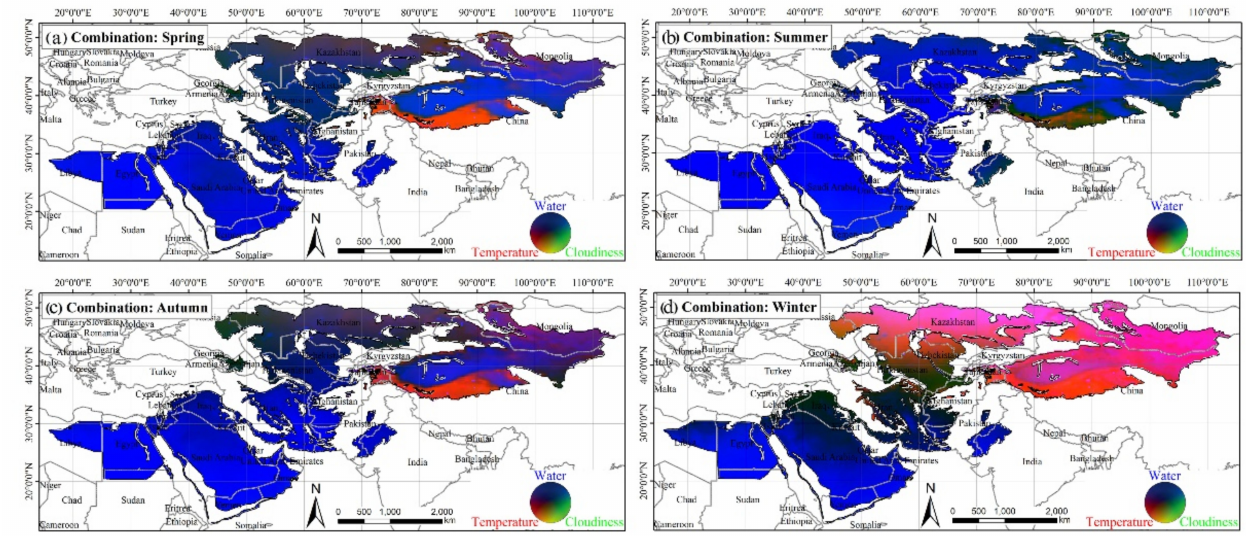
Figure 10. Distribution of combined climatic constraint on vegetation dynamics in different seasons over the Silk Road Economic Belt between 1982 and 2015. Red, green, and blue represent the maximum limits of temperature, cloudiness, and water, respectively, and their combining produce magenta (temperature and water), yellow (temperature and cloudiness), and cyan (water and cloudiness). ( a – d ) indicate the combined constraint of temperature, cloudiness, and water on vegetation dynamics in spring, summer, autumn, and winter,